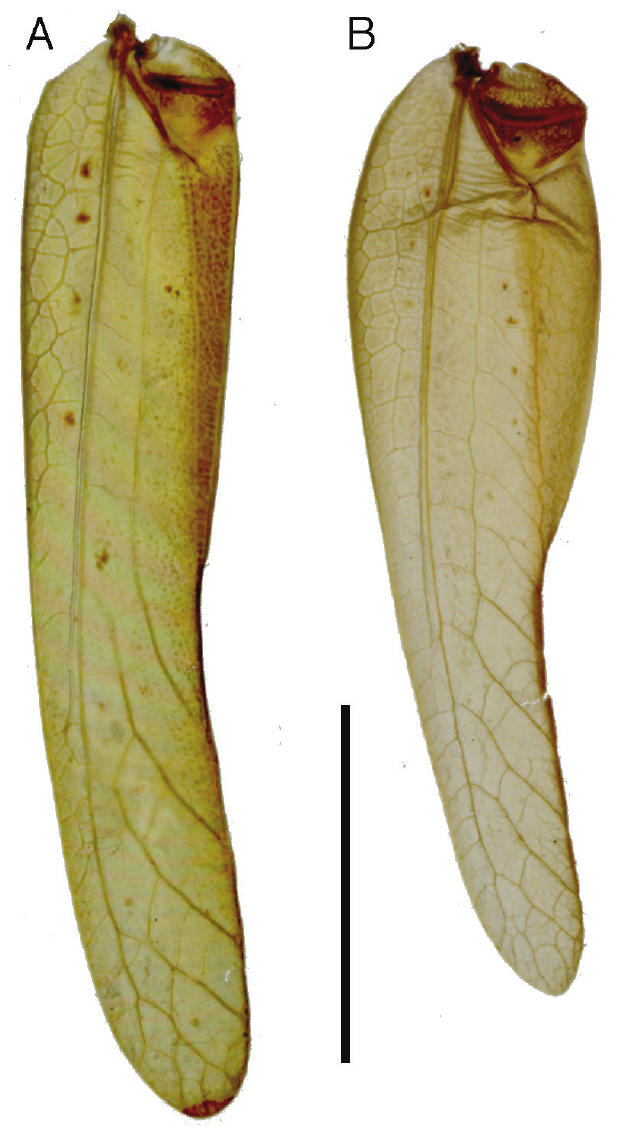
Figure 4. Transmitted light scan of left tegmina. A. Ectadia diuturna sp. n., B. E. fulva (the fold in the basal part is an artifact resulting from the strong curvature of the tegmen). Scale 10 mm.